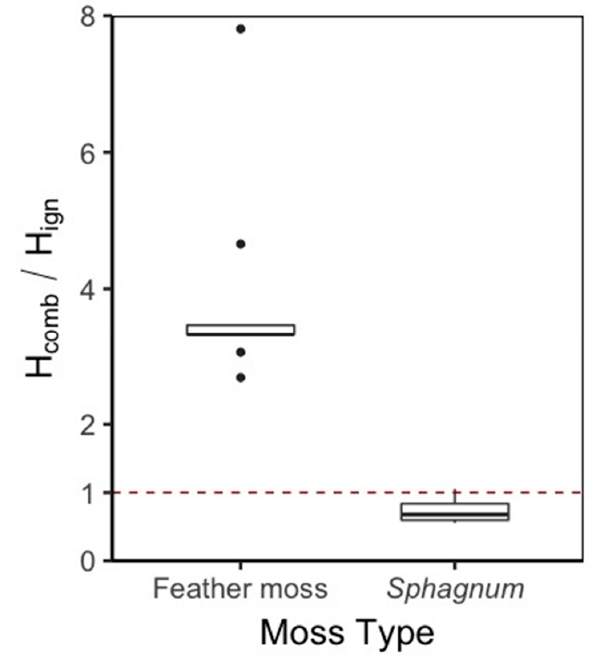
Figure 6. Smouldering potential of near-surface (0–0.06 m) of Sphagnum and feather moss samples after an extended period of drying in laboratory conditions. Significant di ff erence between Sphagnum and feather moss H comb / H ign (t 1 = 12.92; p <